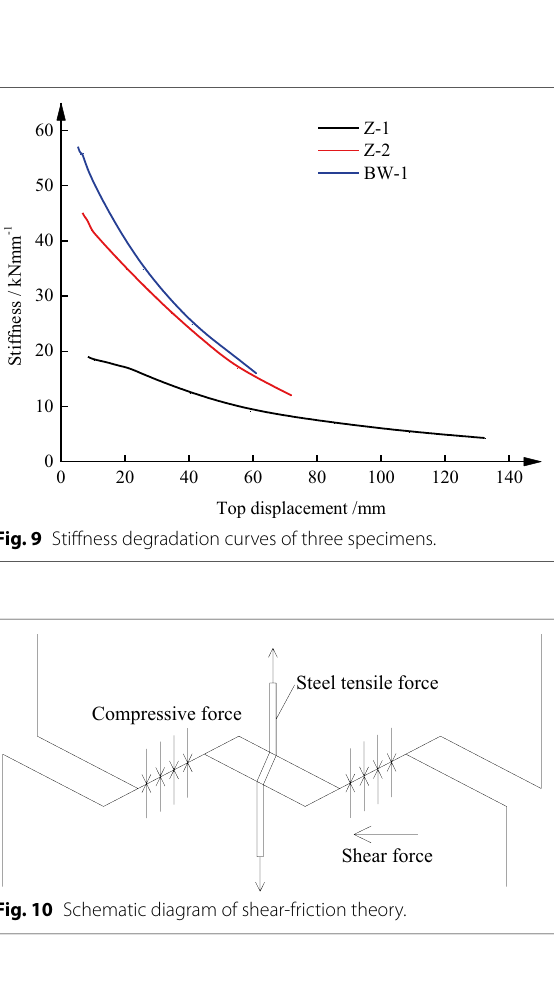
Table 7 The absolute value of tangent stiffness in skeleton